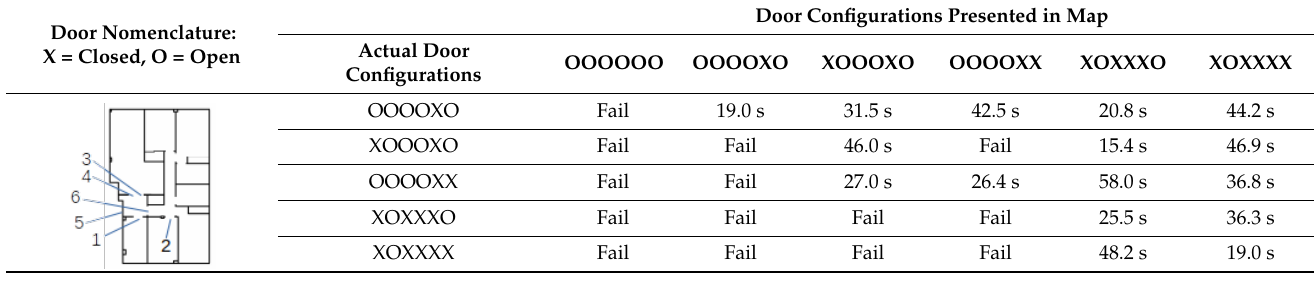
18 of 23 Figure 12. Traditional localization scenario: navigation without map updating ( top ) and traditional navigation with map updating ( bottom ). 5.2. Case Study 2: Kidnapped Robot Scenario Kidnapped robot tests were performed to evaluate how fast and accurately a robot can determine its position in the map when the robot was moved to arbitrary locations. As shown in Figure 10b, six stations were selected for different kidnapped positions. The initial pose represents the initial belief about the current pose from which the robot should recover. For station 1 in a foyer area, a set of sub-tests was performed because there are multiple possible states due to six doors that can be either correctly or incorrectly repre- sented in the map. The doors were either fully open or closed in real life, and the map was altered to show the doors being fully open or closed. At station 1, the robot was placed in the center of the foyer and rotated until it could localize itself. If a full minute of rotation was undertaken without the robot being able to locate itself, the experiment was stopped and marked as a failure. For each case, a total of five identical iterations of the experiment was performed. Each of the cases resulted in the robot being able to localize itself after rotating multiple times. The average time and standard deviations for each iteration are given in Table 3. As shown in the results, all kidnapped robot positioning-utilizing maps accurately presenting the actual door states successfully determined the current positions, and the location error ranged from 2 cm to 8 cm, averaging 5 cm, for all successful locali- zations. For example, in the case where the map showed all doors open, the robot failed